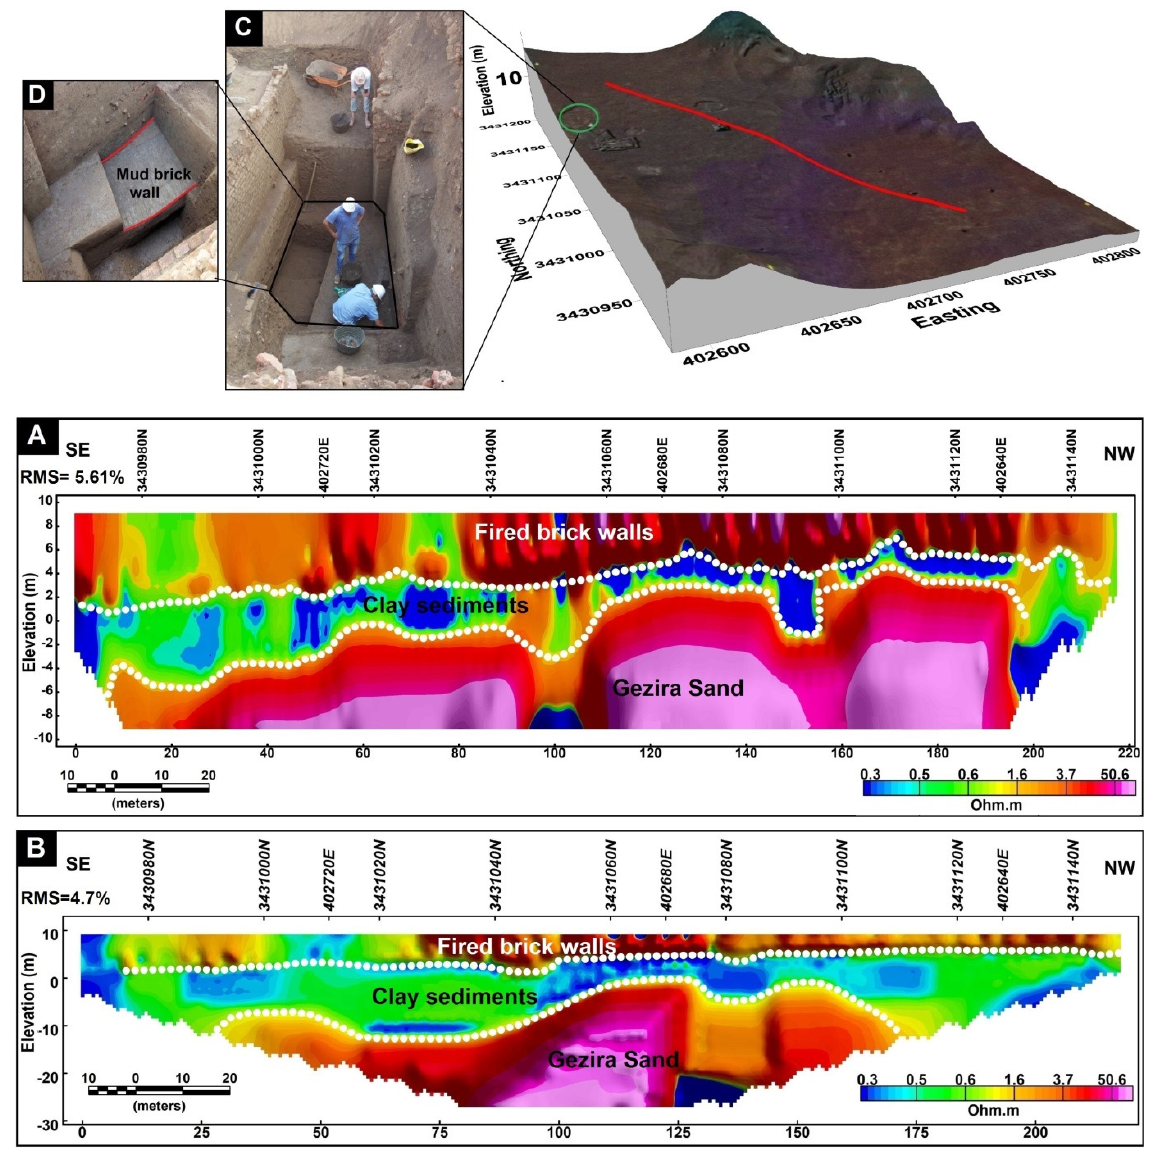
Figure 7. Results of 2D ERT: (A,B) DD and WB inversion models, respectively; and (C,D) photos of excavation during the MATD campaign in September 2019.